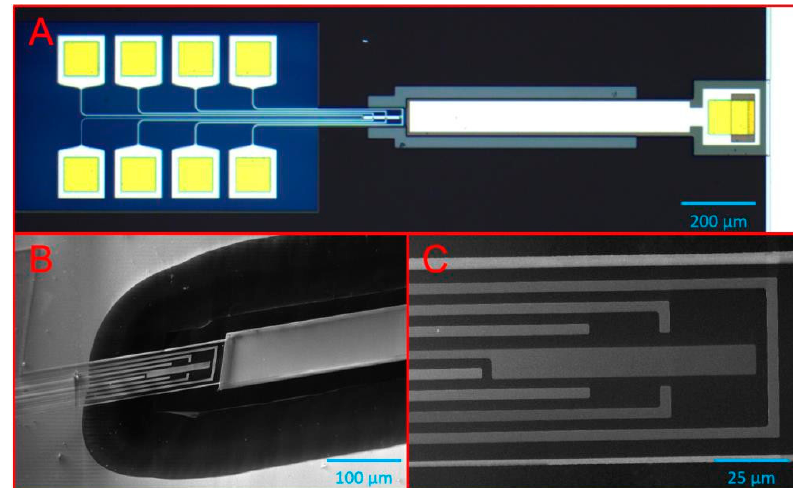
Figure 4. Fabricated structure for 2D material characterization: ( A ) An optical image of entire structure; ( B ) scanning electron microscope analysis of released resonator; ( C ) the detail of stretched part with